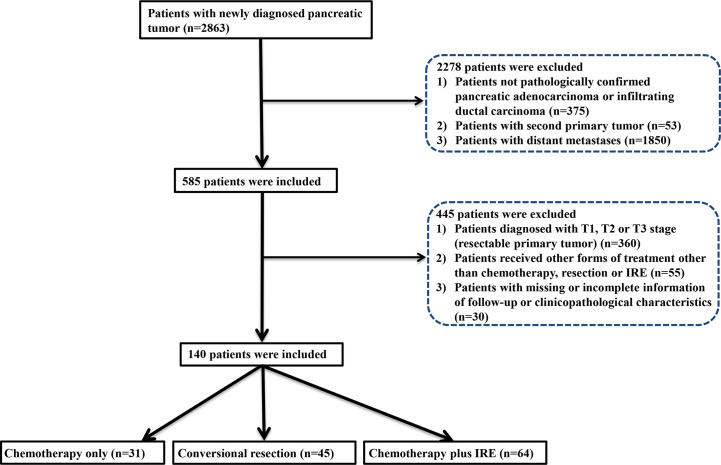
Flowchart of the included patients.